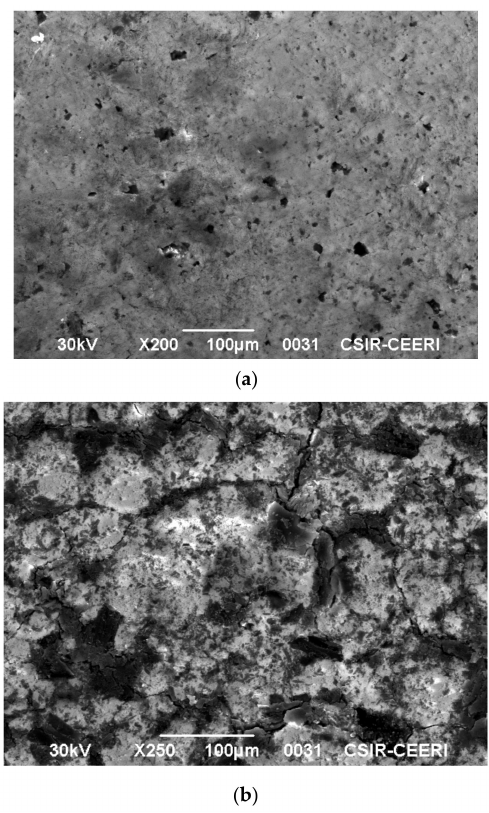
Figure 11. ( a ) Scanning electron microscope image of activated carbon. ( b ) Scanning electron microscope image of indigo carmine adsorbed on activated